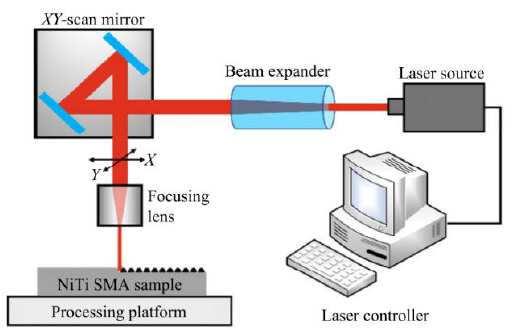
Figure 11. Schematic diagram of laser fabricating (Reprinted with permission from Ref. [63]. 2021, Yang, C.J.). Yang, C.J.).